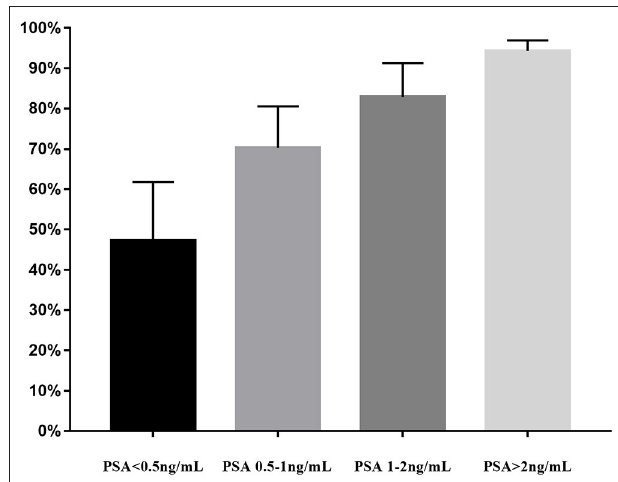
FIGURE 4 | PSA-stratified performance of detection of 18F-DCFPyL PET/CT in biochemically recurrent prostate cancer. PSA, prostate-specific antigen; 18F-DCFPyL, 2-(3-{1-carboxy-5-[(6-[18F] fluoro-pyridine-3-carbonyl)-amino]-pentyl}-ureido)-pentanedioic acid;